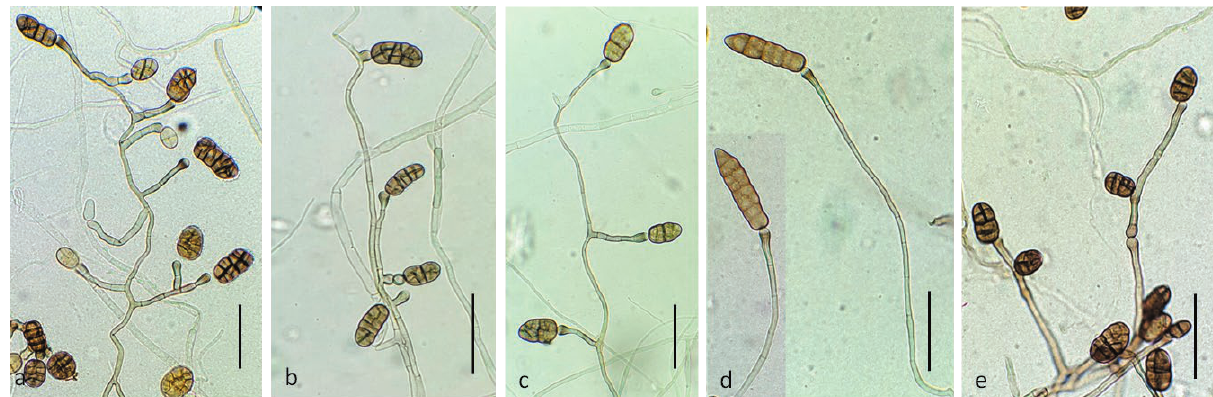
Figure 4. Stemphylium spp. on potato carrot agar, after 7 d incubation at room temperature; conidia and conidiophores with swollen apical cells. Stemphylium eturmiunum NB731 (a), and NB712 (b); S. vesicarium NB737 (c), NB713 (d), and NB654 (e)€; S. gracilariae , NB690 (f), NB696 (g), and NB644 (h); S. lycopersici NB711 (i); and S. lycii NB683 (j). Bars = 50